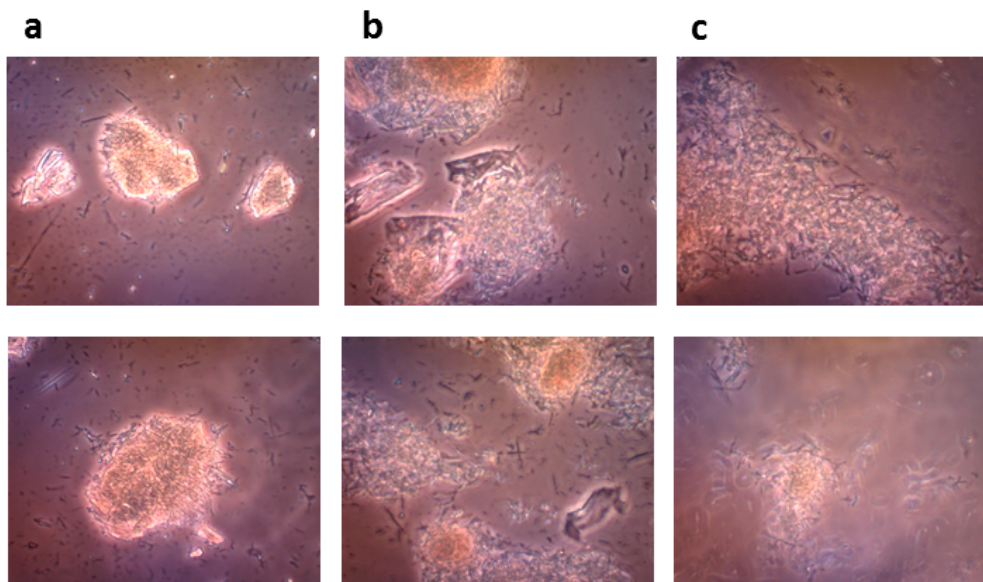
Figure 6. Microscopic monitoring of “Solid-State Biocatalysis” after ( a ) 0 h, ( b ), 2 h and ( c ), 5 h of reaction (rutin 100 g/L, crude recombinant rutinosidase). OLYMPUS CX41 optical microscope equipped with OLYMPUS U-CMAD3 digital camera, magnification 400×.